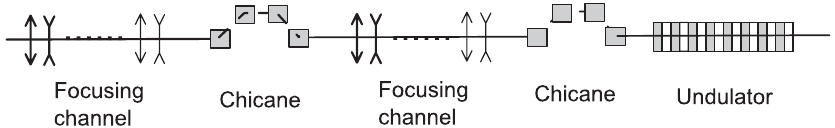
FIG. 1. Conceptual scheme of an LSC